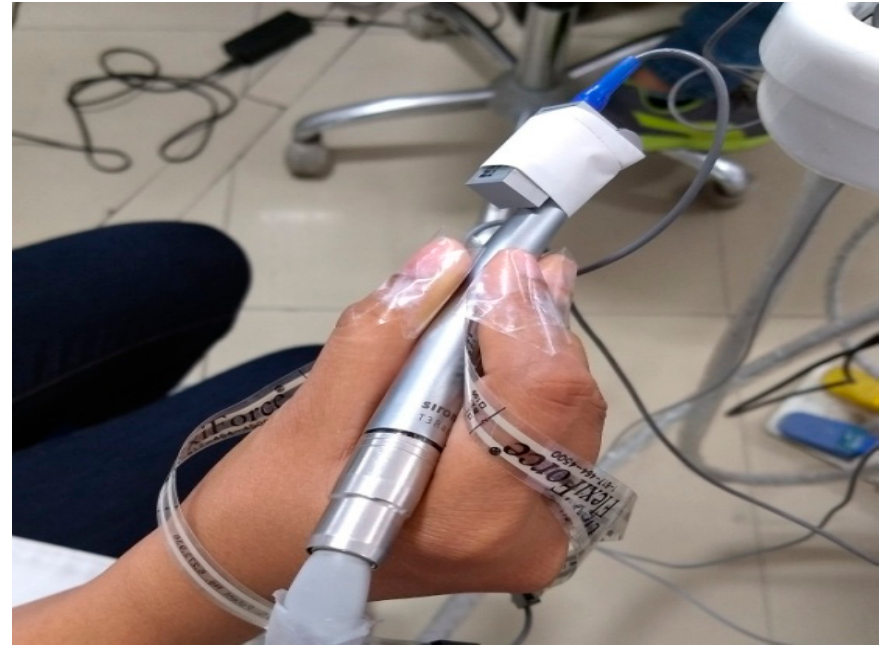
Figure 2. Accelerometer attachment.